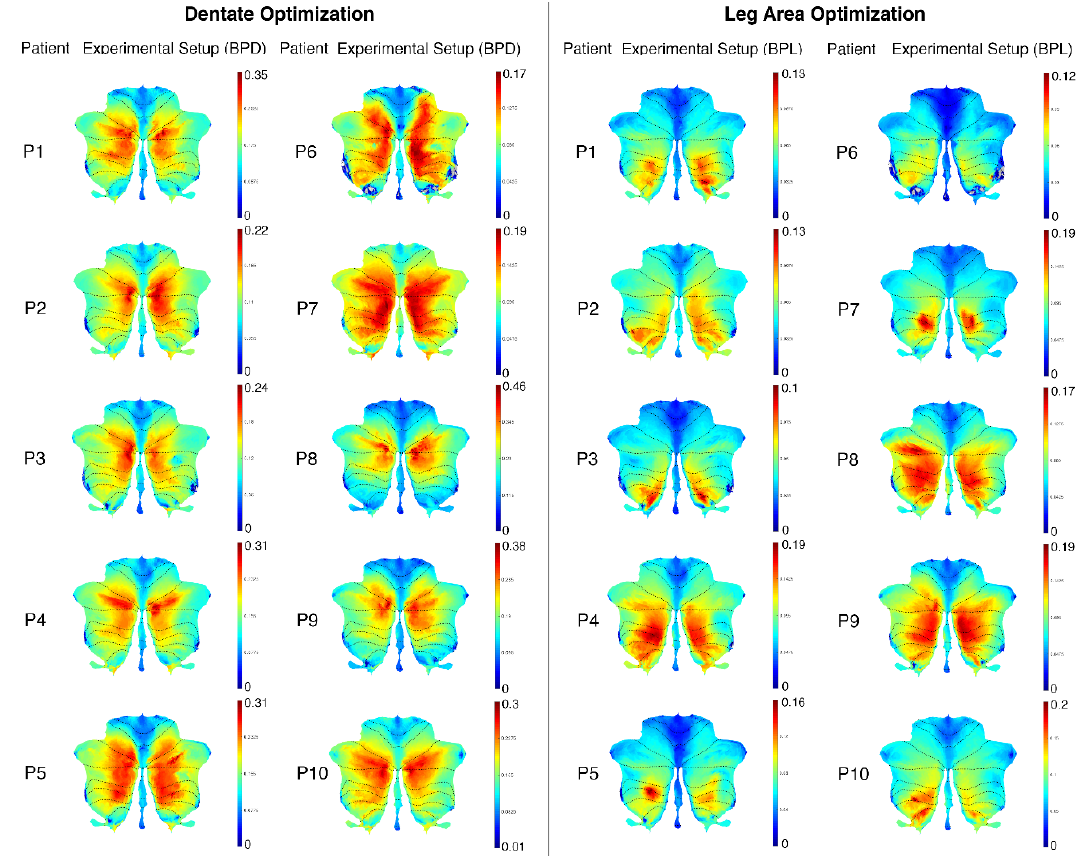
Figure A11. Post-stroke subject-specific SUIT flatmaps for all the 10 participants.